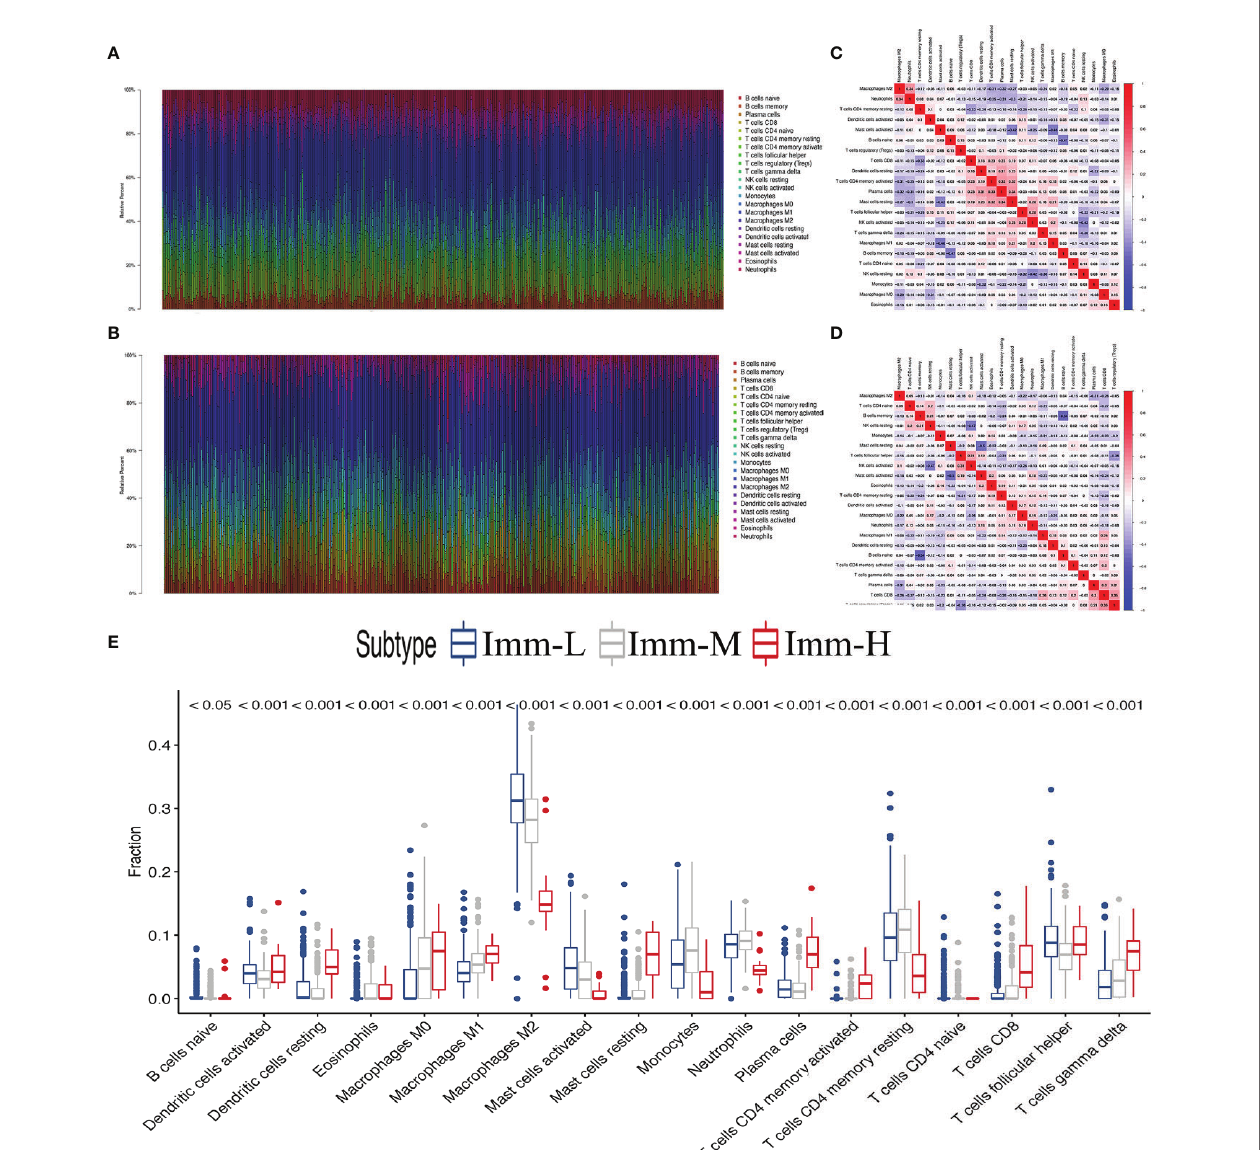
FIGURE 5 | The landscape of immune cell in fi ltration in the glioma microenvironment. (A, B) The proportions of 22 in fi ltrating immune cells in the glioma microenvironment in the TCGA microarray and CGGA RNA-seq cohorts respectively. (C, D) Correlation heatmaps of the TCGA microarray and CGGA RNA-seq cohorts respectively. (E) Immune cell in fi ltration level of glioma microenvironment among immune phenotypes in the TCGA microarray cohort based on the CIBERSORT